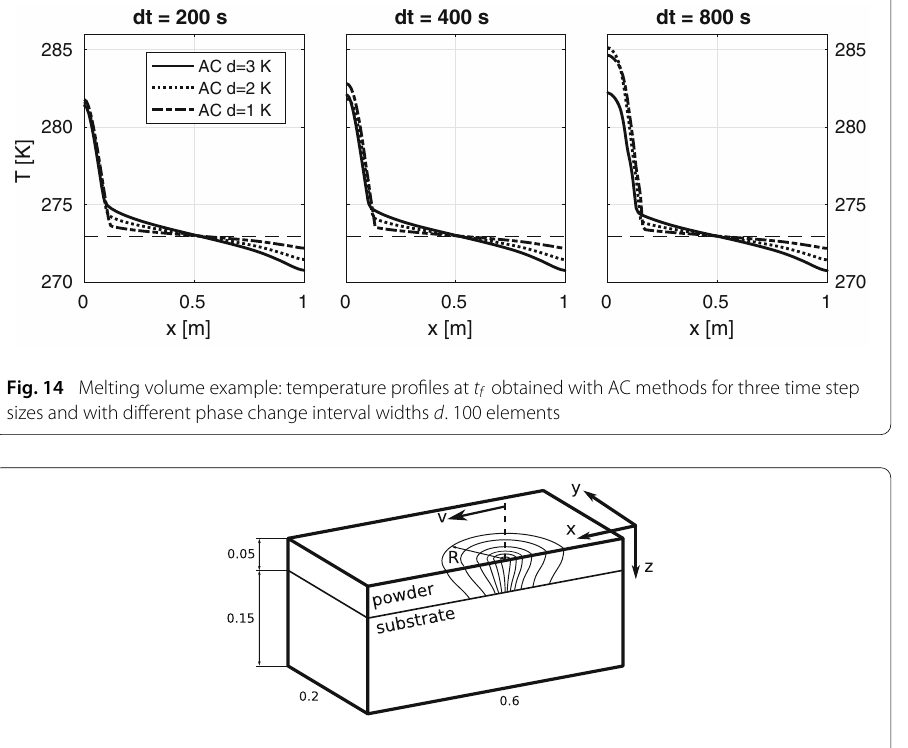
Fig. 15 Geometry and moving laser heat source for single track scan example (all dimensions given in mm) [21] correlates with higher maximum temperatures which in turn implies that not all latent heat has been